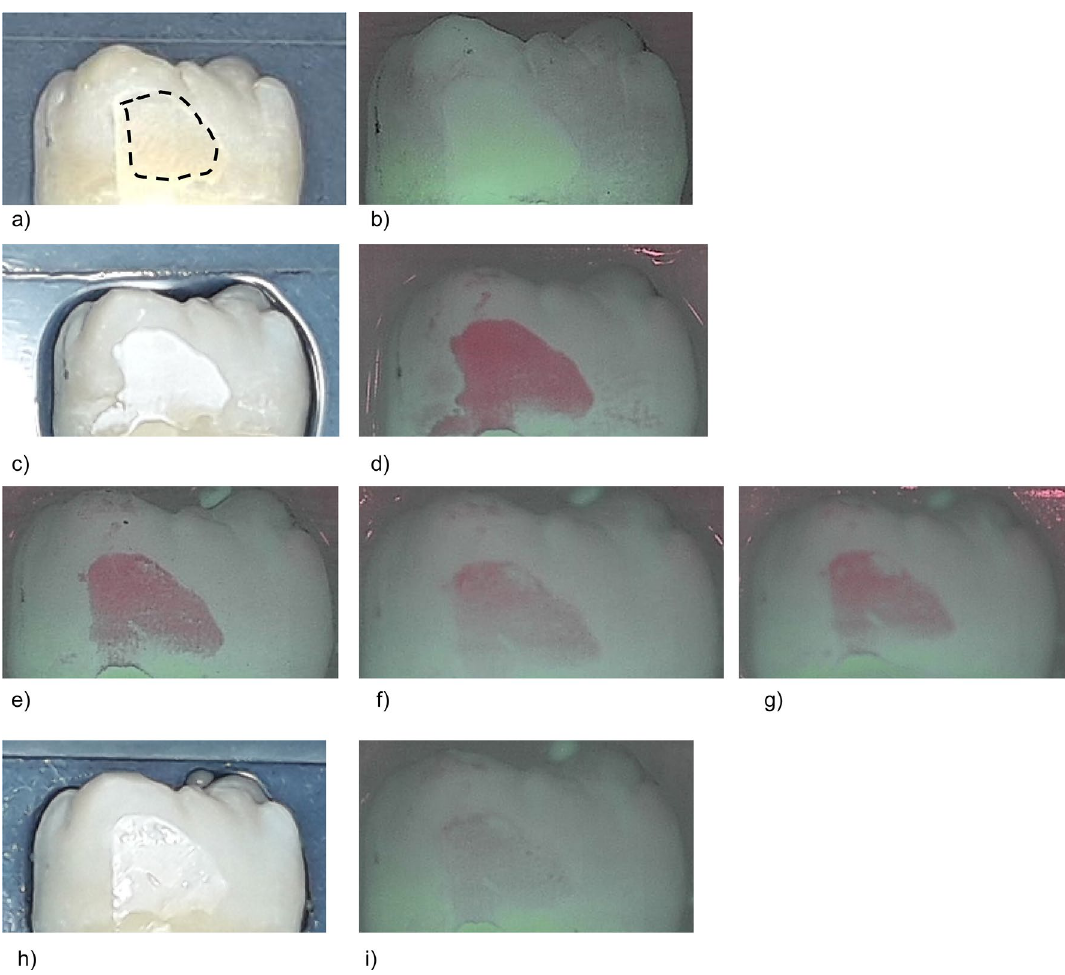
Figure 3. Standard image and QLF image of a representative sample in group III (Cervitec F, sample #09) at different investigation times. The dashed line indicates the ground surface where the QLF measurements were performed. (3 a ) Prior to demineralization. ( b ) Corresponding QLF-image: ΔF = 0.0%; ΔFmax = 0.0%. ( c ) After demineralisation (T-demin). ( d ) Corresponding QLF-image (T-demin): ΔF = ΔF = − 16.5%; ΔFmax = − 30.5%. ( e ) QLF image T07: ΔF = − 14.7%; ΔFmax = − 27.1%. ( f ) QLF image T14: ΔF = − 8.9%; ΔFmax = − 19.8%. ( g ) QLF image T21: ΔF = − 9.8%; ΔFmax = − 19.4%. ( h ) 28 days after demineralisation (T28). ( i ) Corresponding QLF- image (T28): ΔF = − 6.3%; ΔFmax = −